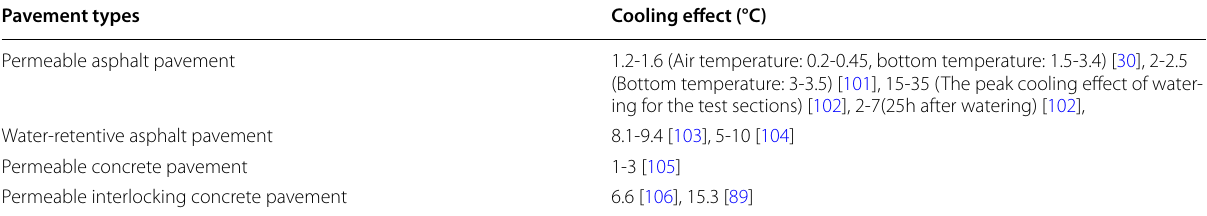
Table 5 Cooling effect of different permeable pavements and water retaining pavements Pavement